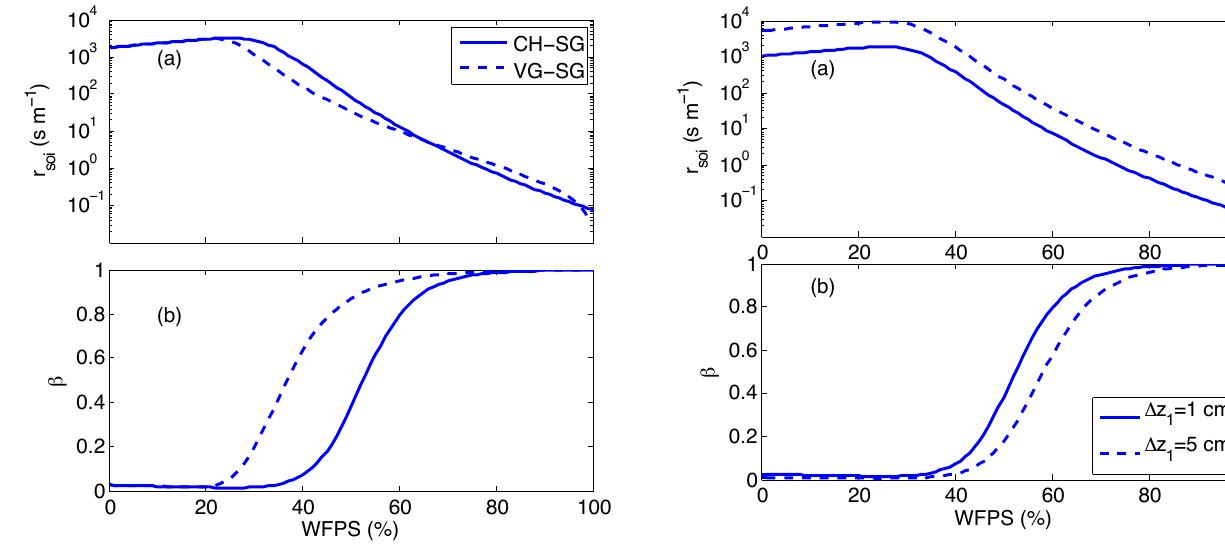
50 s m -1 and 4 a =